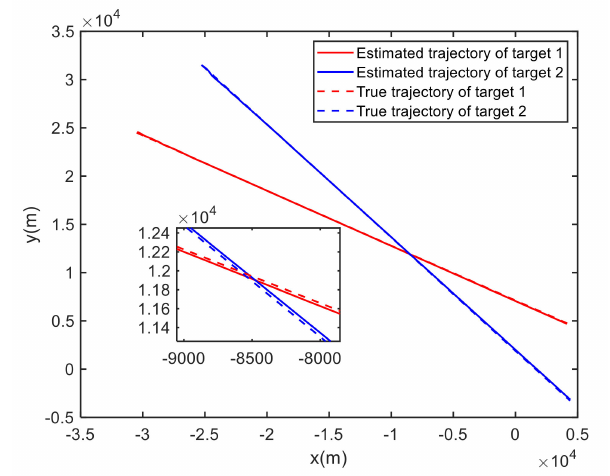
Figure 9. True and estimated tracks using the RL-JPDA in Case 2.